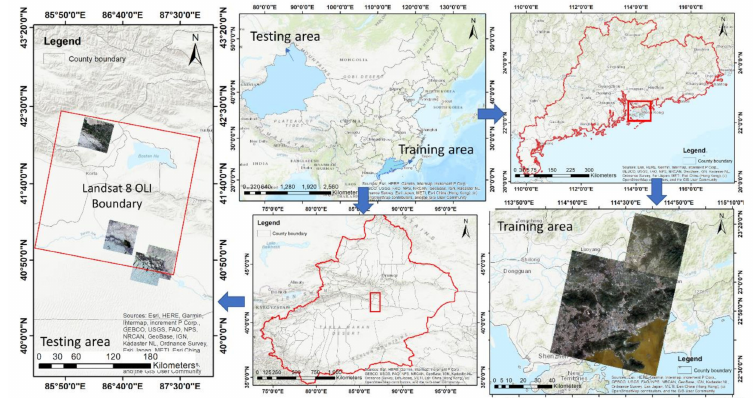
Figure 3. Study area and the image coverage of GF 1.